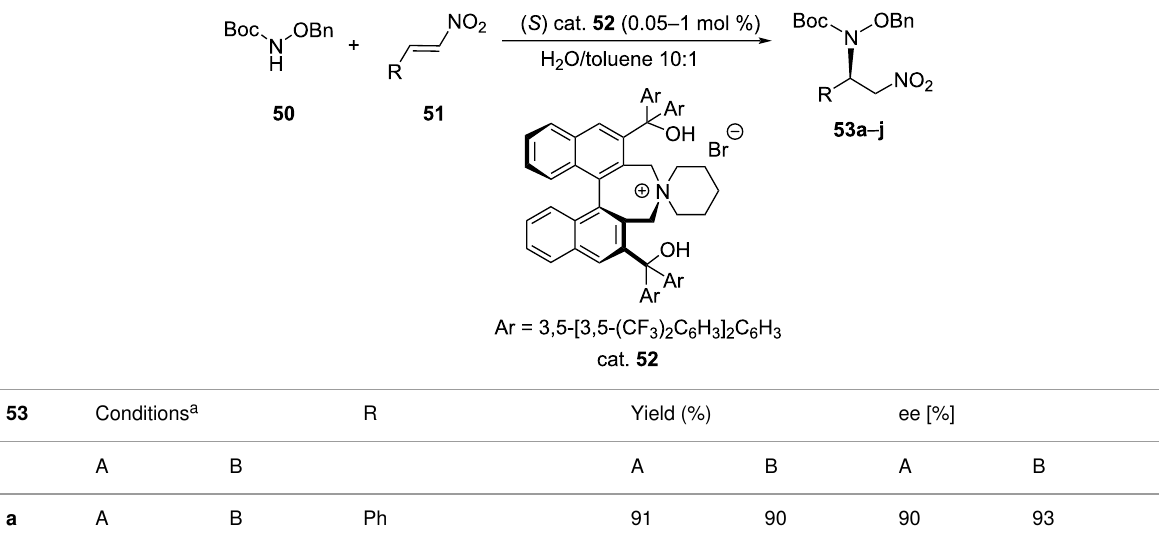
Table 11: Asymmetric aza-Michael addition reaction catalyzed by phase-transfer